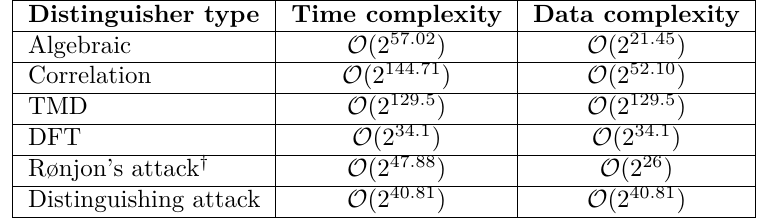
Table 8: Summary of the data and time complexities of different